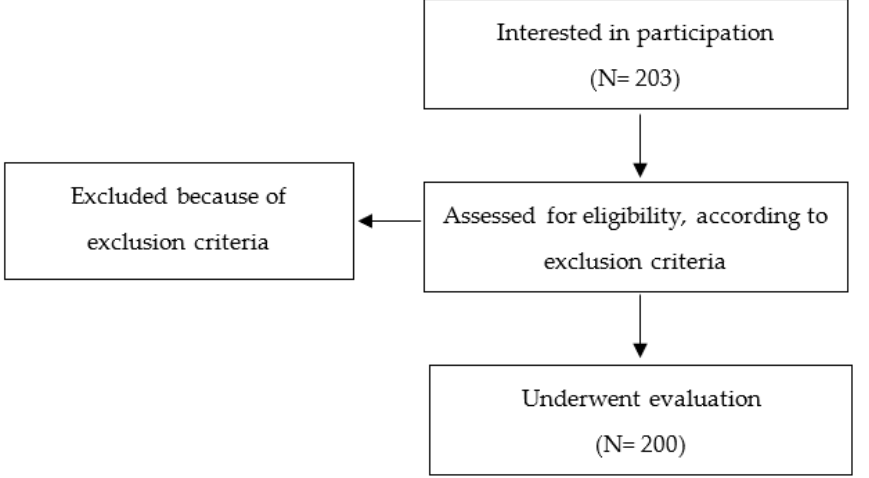
Figure 1. Flow chart showing a description of study design, recruitment and